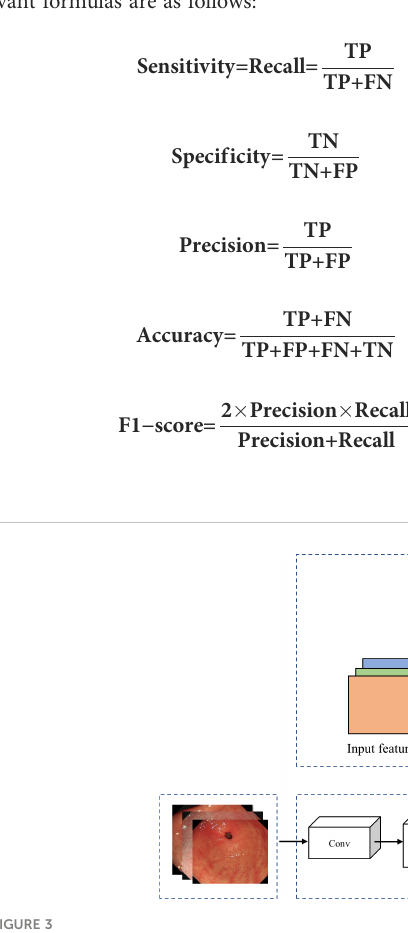
FIGURE 3 GAM-Ef fi cientNet architecture. Conv represents convolution; Pooling is average pooling layer; FC is full connection layer; Ä represents element-wise multiplication; ×n is repeat times.